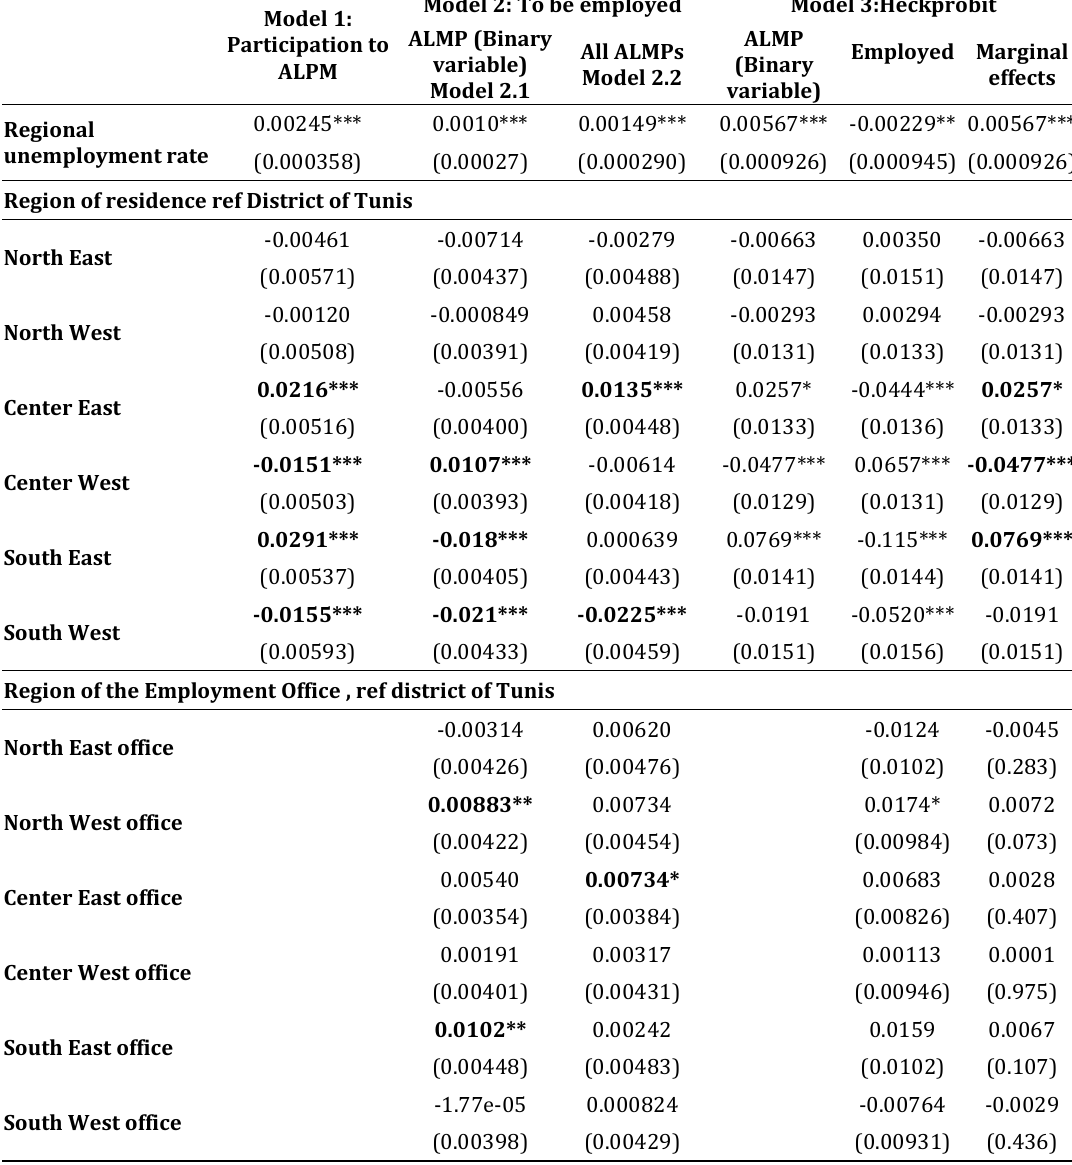
Table 5: Impact of regional characteristics on ALMPs participation and professional insertion Model 2: To be employed Model 3:Heckprobit Model 1: ALMP (Binary Participation to Employed Marginal variable) (Binary ALPM Model 2.2 Model 2.1 variable)